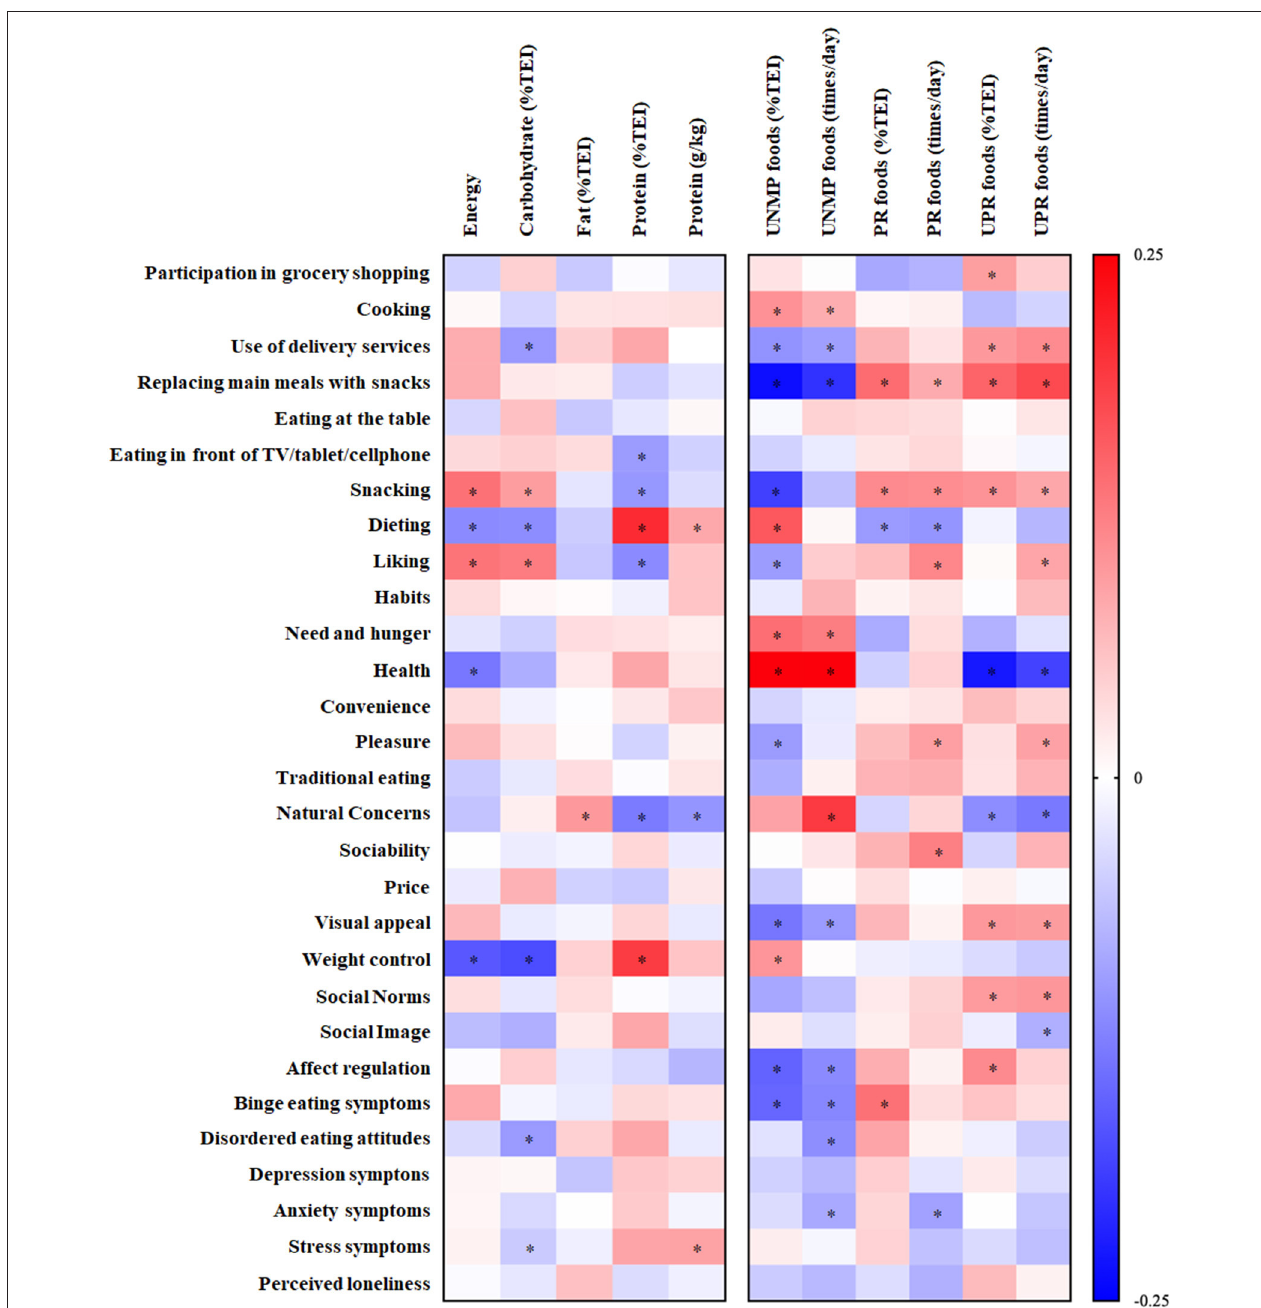
FIGURE 1 | Associations between food consumption (dependent variables) and eating habits and determinants (independent variables). Data presented as standardized β (95% CI); * p < 0.05. UNMP, unprocessed and minimally processed foods; PR, processed foods; UPR, ultraprocessed foods.